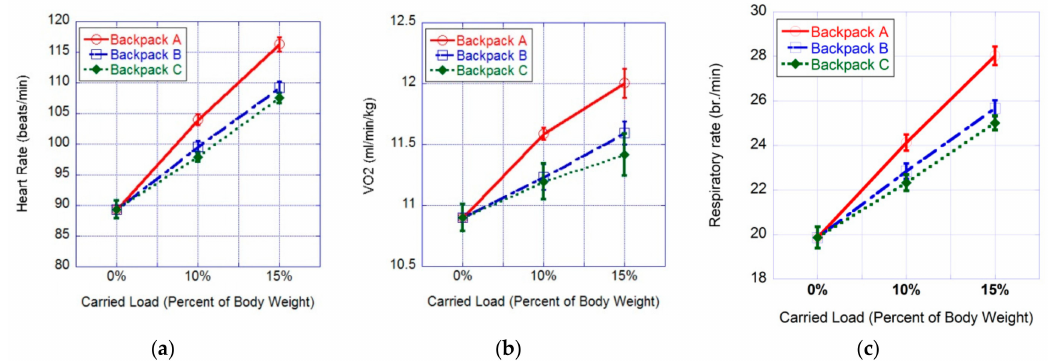
Figure 3. E ff ects of di ff erent backpacks, represented by the percent of carried load interaction with respect to various physiological responses. ( a ) Heart rate response; ( b ) Oxygen uptake response; ( c ) Respiratory rate